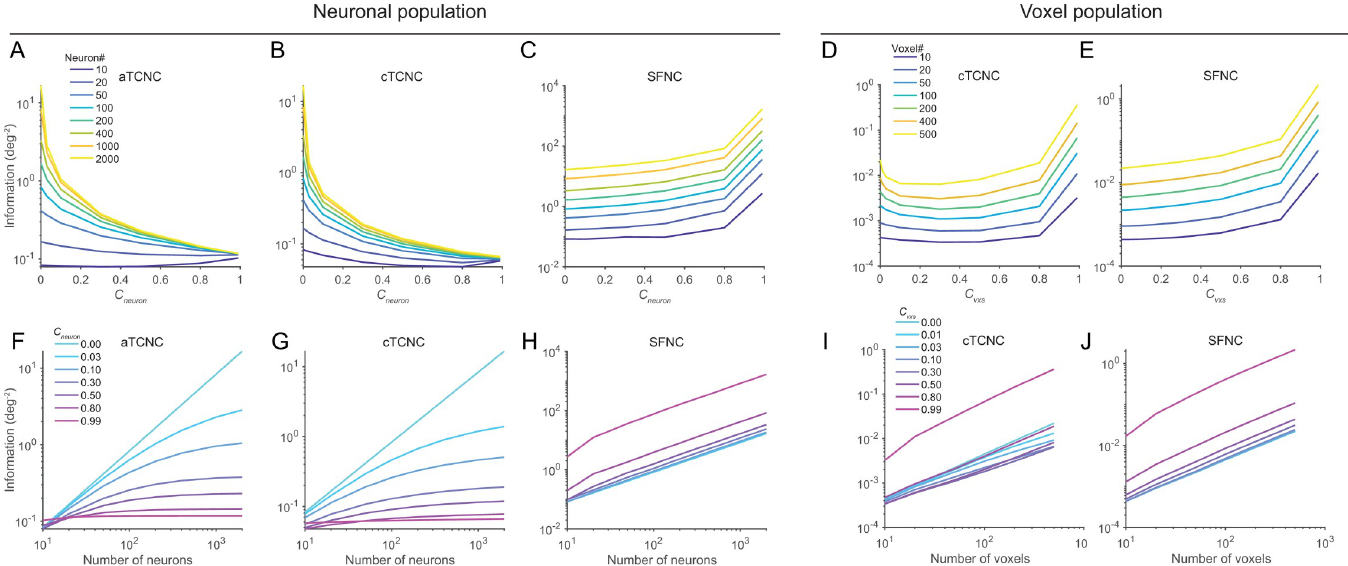
Fig 7. Amount of information in neuronal and voxel populations with diverse forms and strength of NCs. The upper and the bottom rows depict the amount of information as a function of increasing strength of NCs and the increasing number of units in the population, respectively. Panels A-C and F-H illustrate the amount of information in a neuronal population and correspond to Fig 4. Panels D-E and I-J illustrate the amount of information in a voxel population and correspond to Fig 5. Note that here we only illustrate the information in the stimulus-estimation task. We consider three types of NC—aTCNC (panels A, F), cTCNC (panels B, G), and SFNCs (panels C, H) in the neuronal population, as already shown in Fig 4. Similar treatments are performed for the voxel population, as shown in Fig 5. The calculation of information largely mirrors the decoding results shown in Fig 4 and Fig 5. Critically, the amount of information in the voxel population exhibits U-shaped functions of increasing strength of cTCNCs (panel D) and cTCNCs do not limit information as the number of voxels increases (panel I). These results clearly differ from the effects of aTCNCs (panels A, F) and cTCNCs (panels B, G) in the neuronal population.